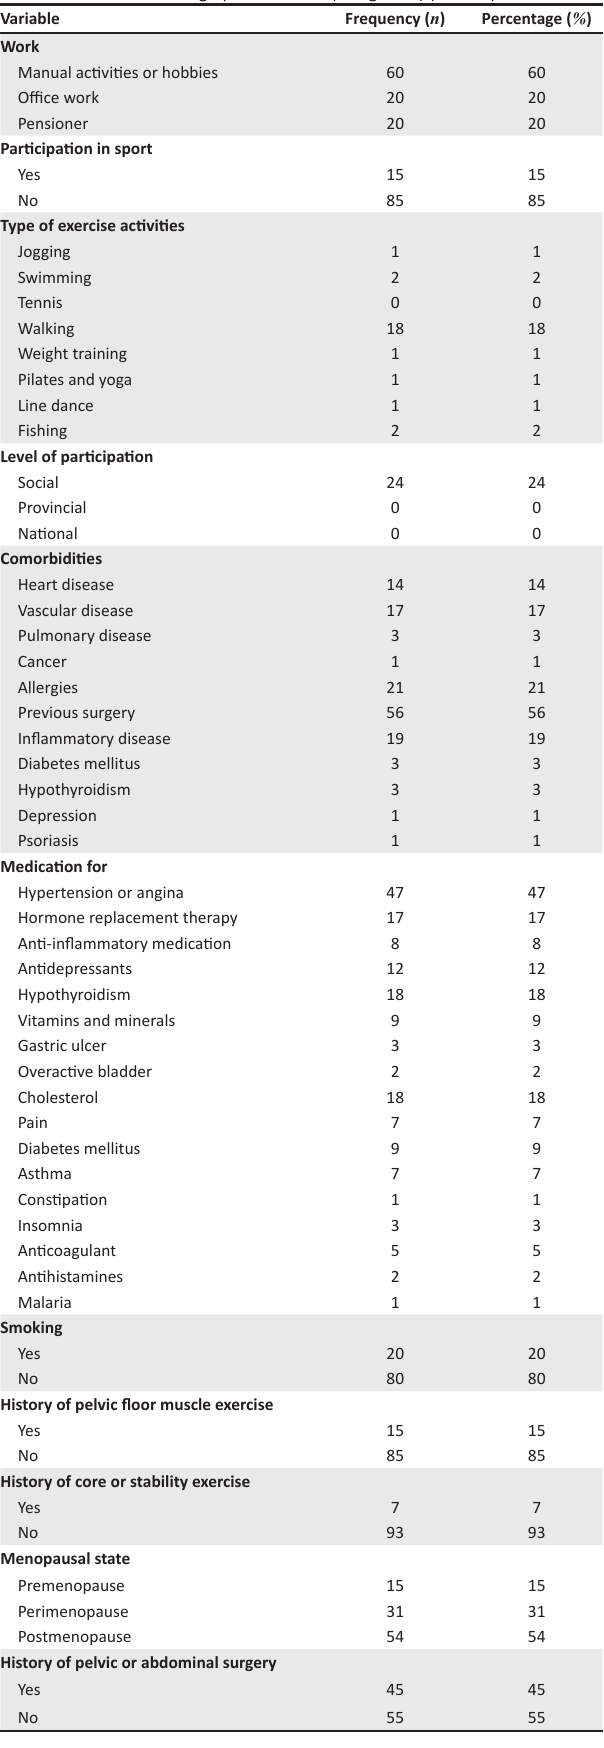
TABLE 1: Results for demographic variables (categorical) ( n =